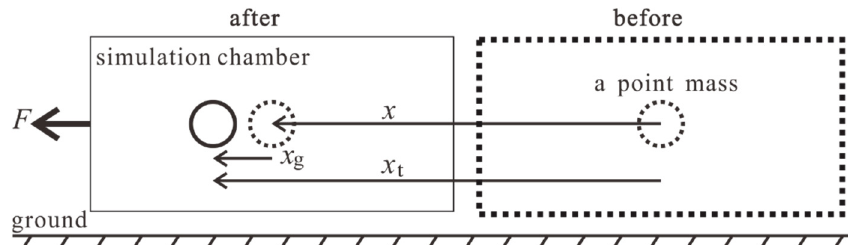
Figure 5. The relationship between x , x t , and x g .